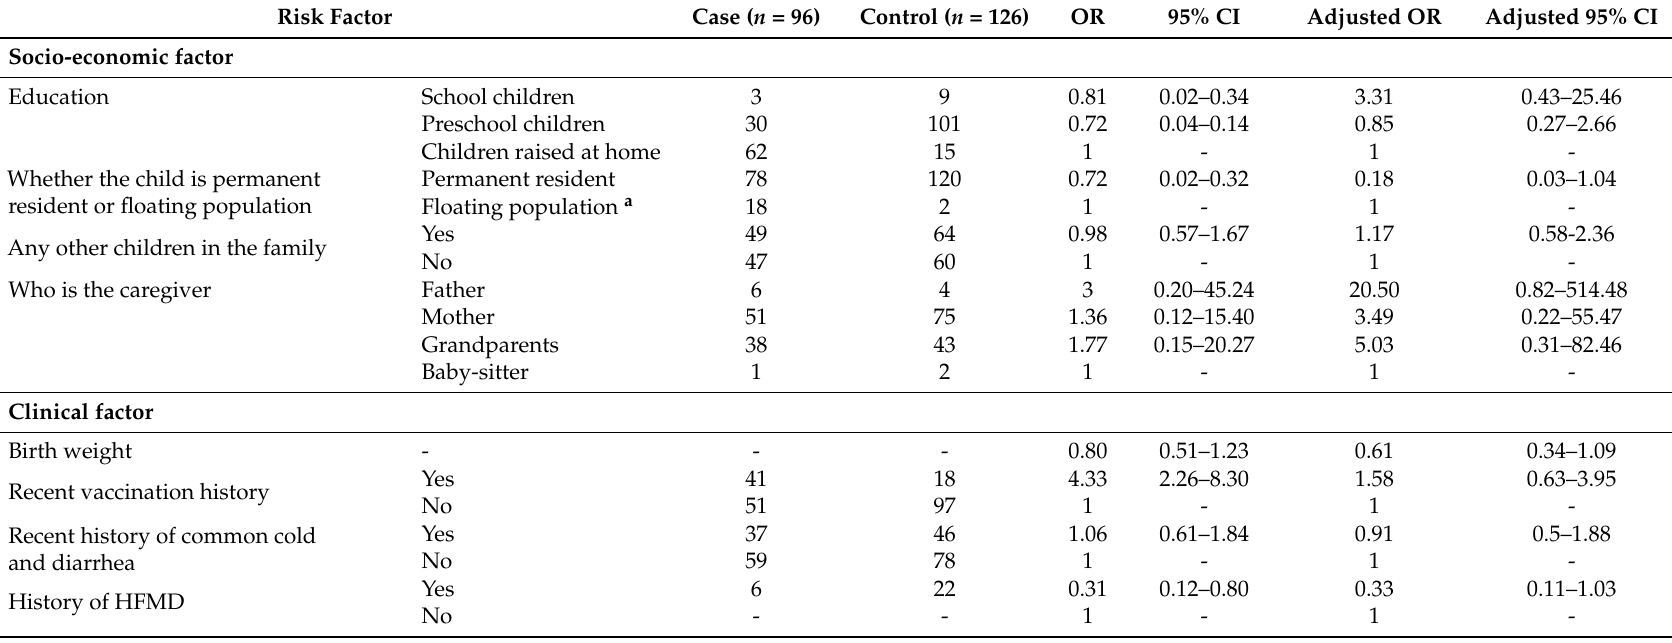
Table 2. Univariate and multivariate analyses on factors associated with HFMD infection in preschool-aged children adjusted by